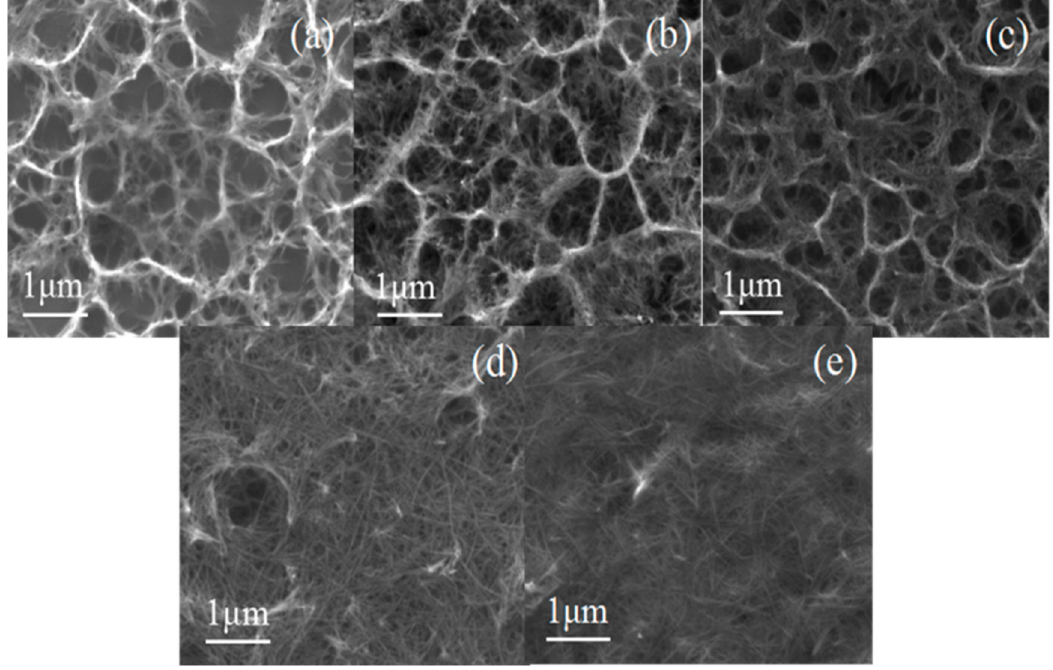
Figure 6. SEM images at different temperatures. ( a ) 130 °C; ( b ) 140 °C; ( c ) 150 °C; ( d ) 160 °C; ( e ) 170